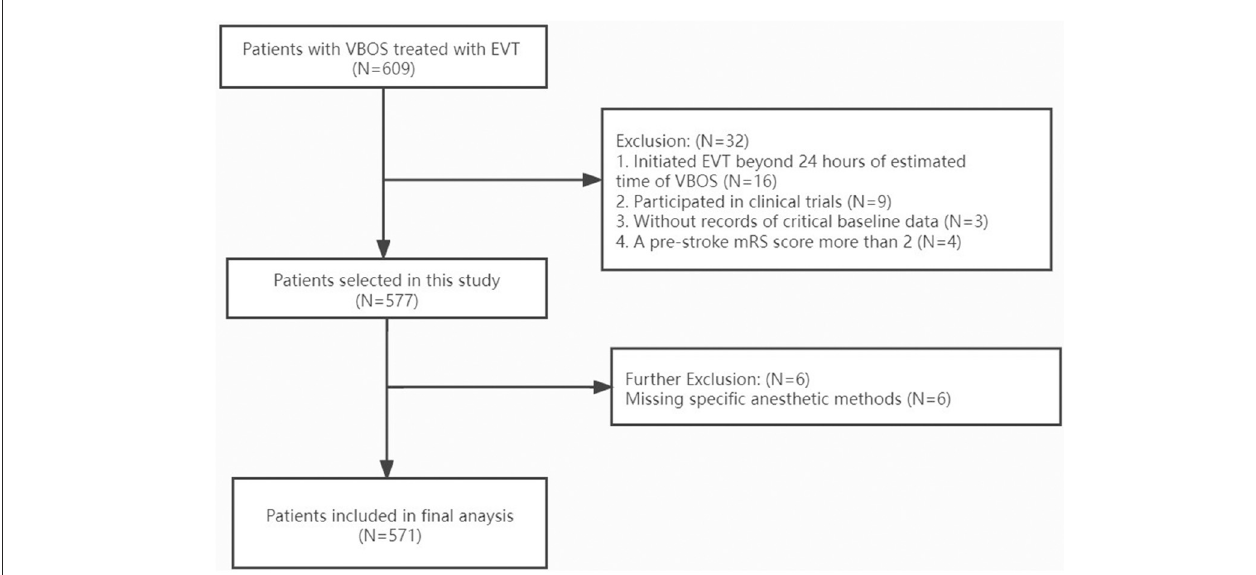
FIGURE1 Flow chart of patient inclusion. VBAO indicates vertebrobasilar occlusion strokes; EVT, endovascular treatment; mRS, modified ranking